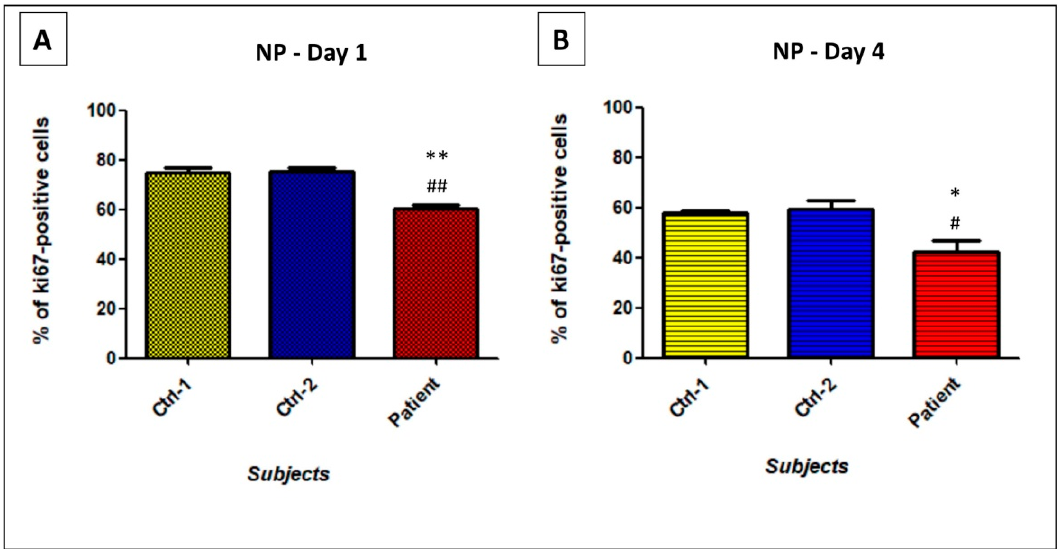
Figure 6. Percentage of Ki-67 expressing-NPs of Ctrl-1, Ctrl-2, and Patient, at day 1 ( A ) and day 4 ( B ) after the beginning of the differentiation process. Lower growth rate in patient’s neural cells, carrying the p.Ser194* mutation in GDAP1 , was observed. ** p < 0.01 vs. Ctrl-1; ## p < 0.01 vs. Ctrl-2; * p < 0.05 vs. Ctrl-1; # p < 0.05 vs.